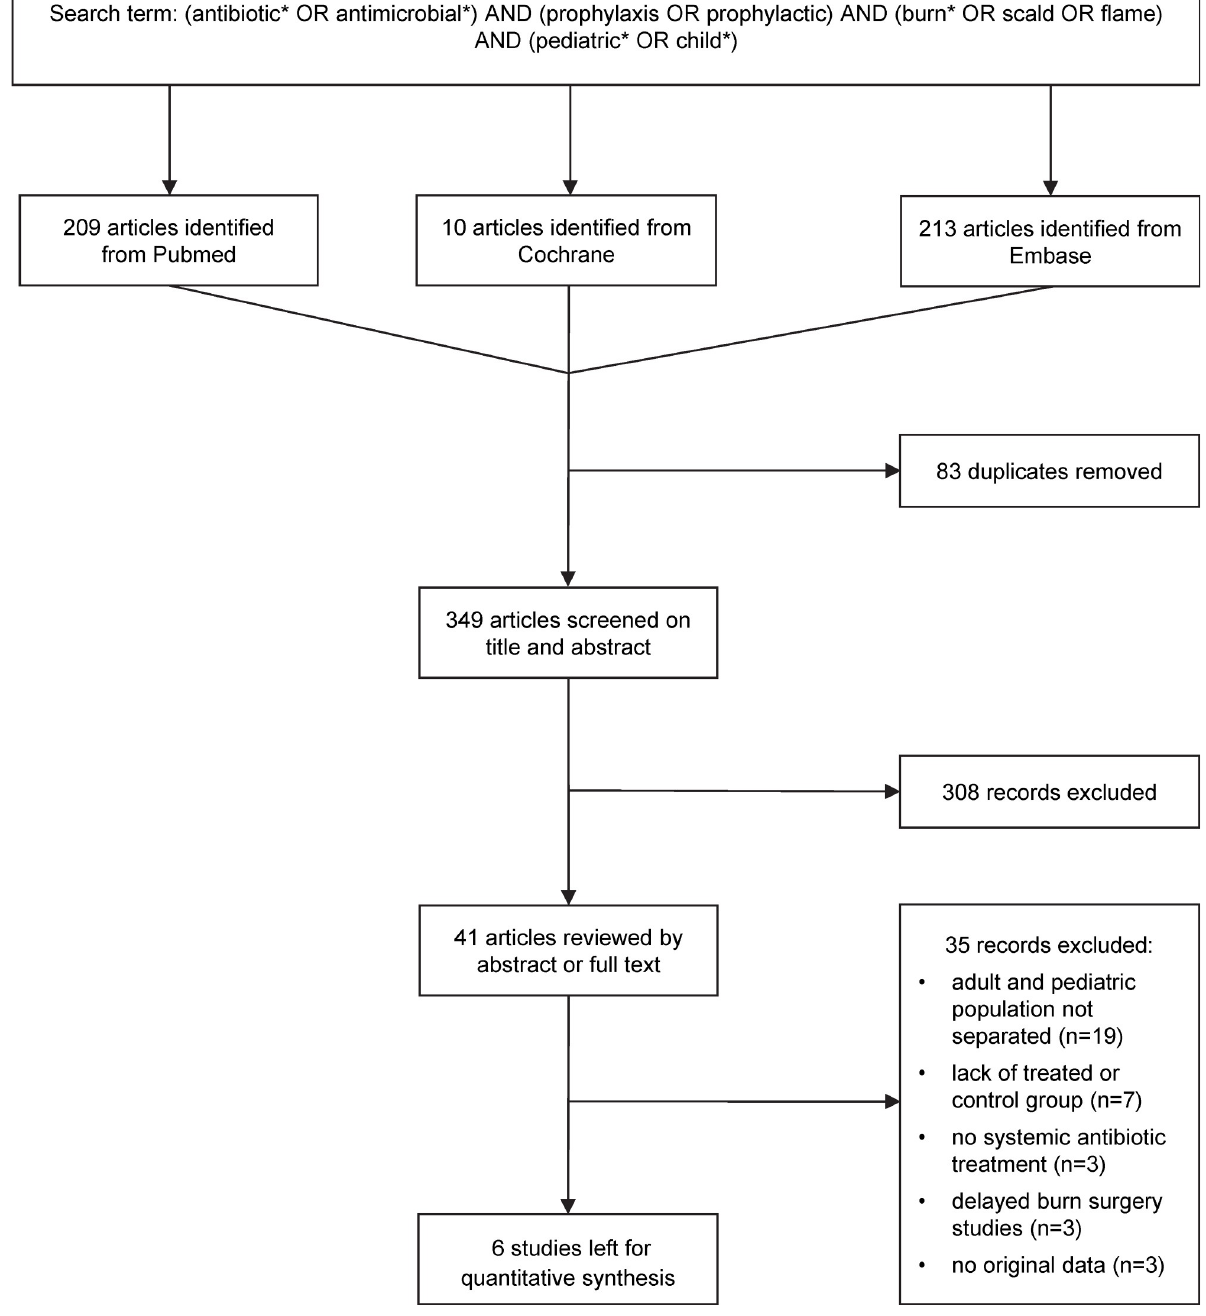
Fig 1. Flow chart of study selection and inclusion.